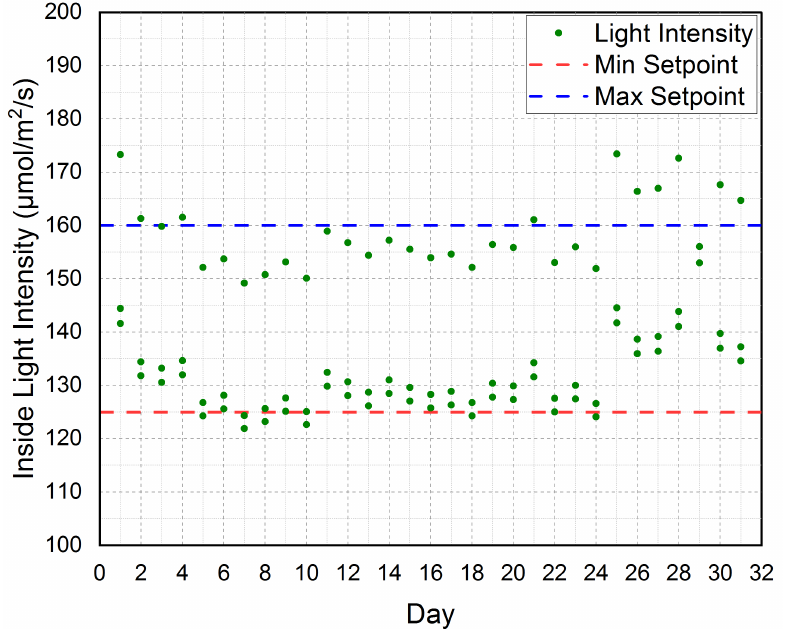
Figure 13. The three months average for inner light intensity (Light Intensity) according to the minimum setpoint (Min Setpoint) and maximum setpoint (Max Setpoint) considered in our platform.